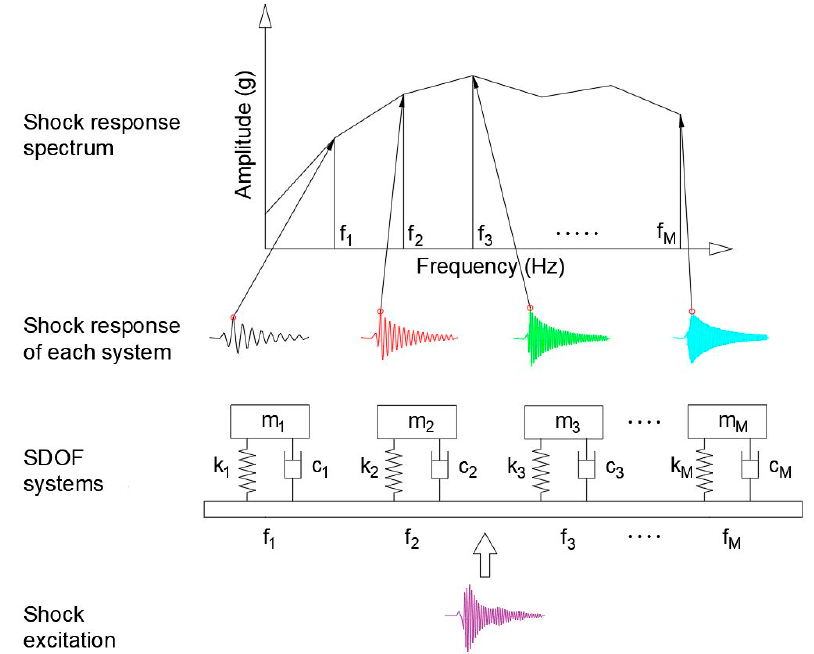
Figure 3. Shock ‐ response spectrum (SRS). Figure 3. Shock-response spectrum